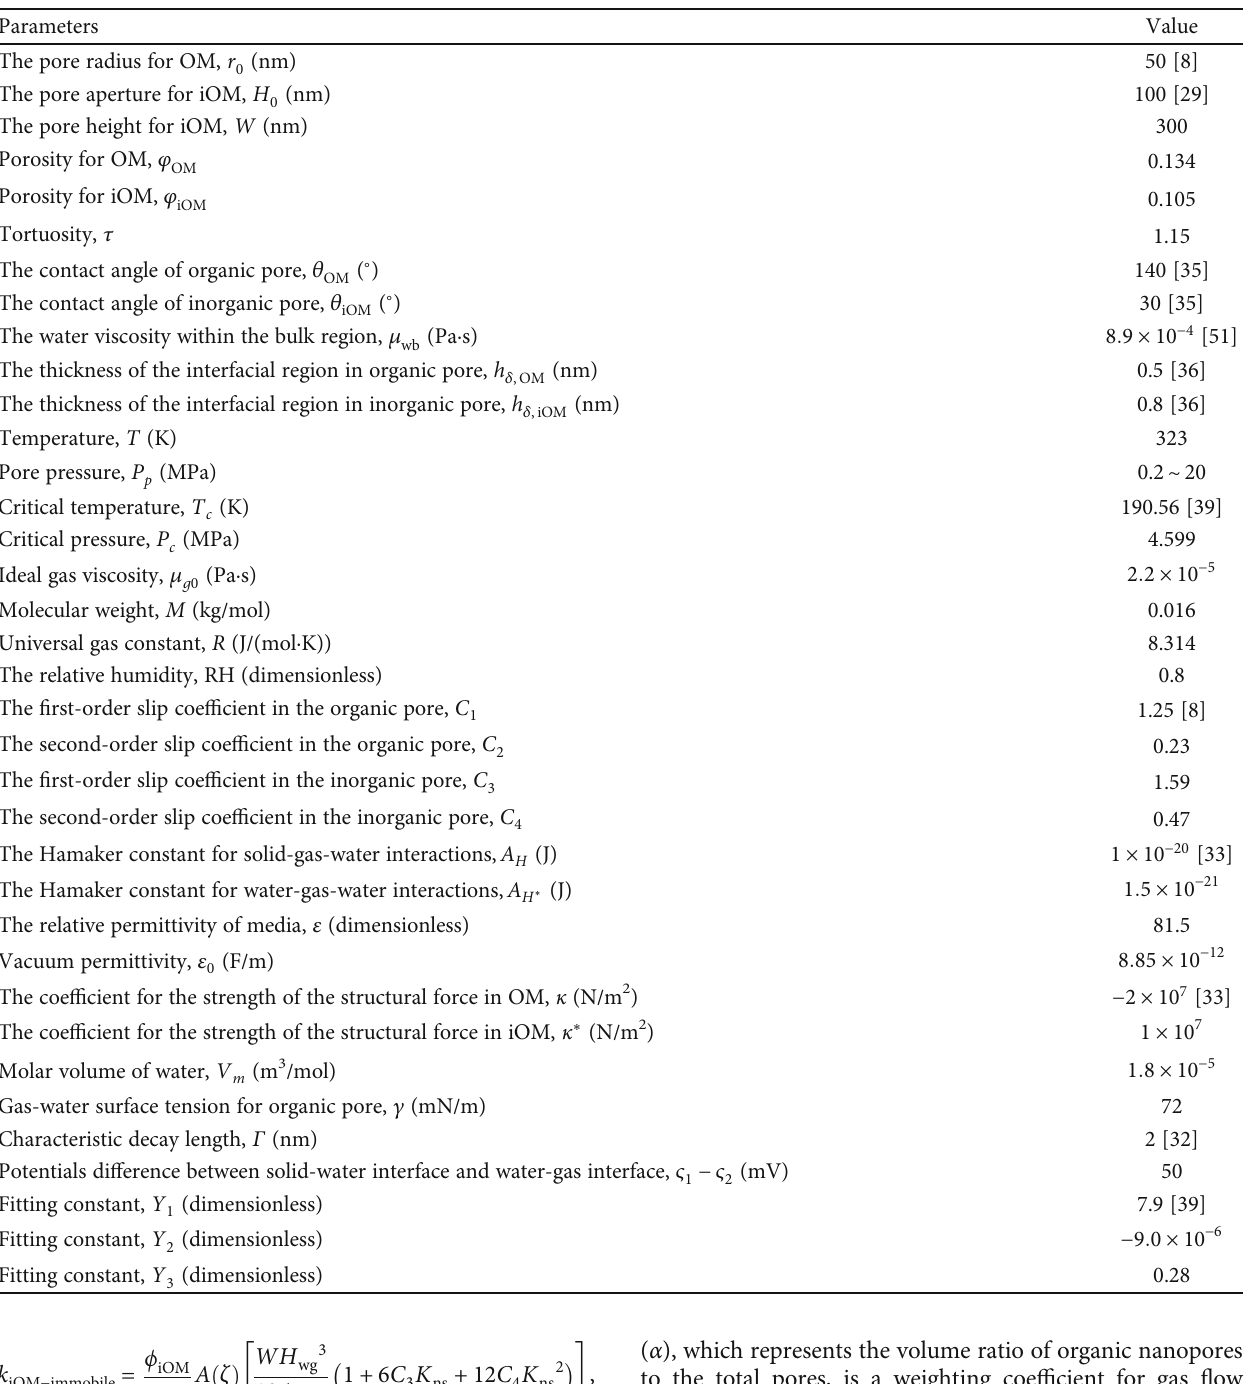
Table 1: Parameters used in the proposed models for